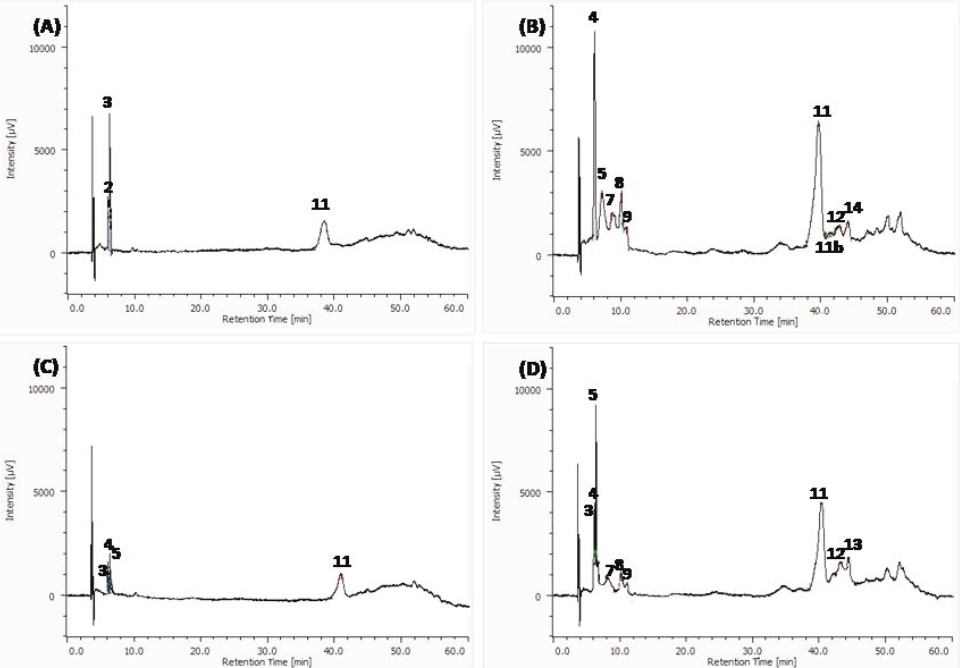
Fig. 2 - Typical chromatographic patterns at 450 nm of carotenoid extracts of (A) LeM ‘Palmer’, (B) MoM ‘Palmer’, (C) LeM ‘Haden’ and (D) MoM ‘Haden’ mangoes. For peak assignment see Table 1.